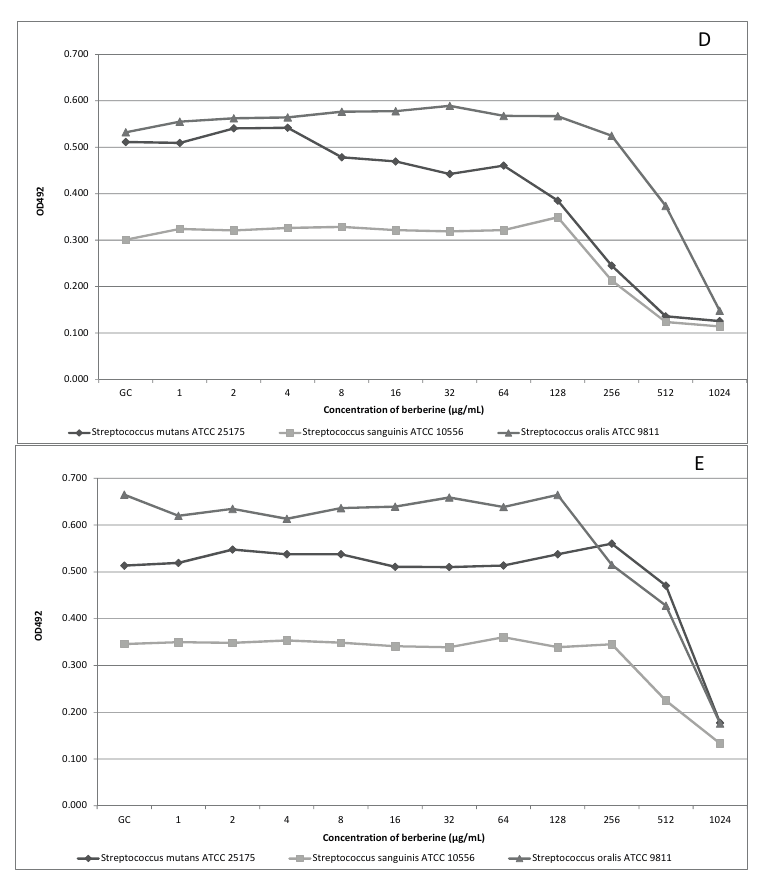
Figure 1. Concentration-response growth curves for oral streptococci exposed to various BECl concentrations 1–1024 µg/mL. Time-kill curves: ( A ) after 0 h of incubation; ( B ) after 2 h of incubation; ( C ) after 6 h of incubation; ( D ) after 12 h of incubation and ( E ) after 24 h of incubation.